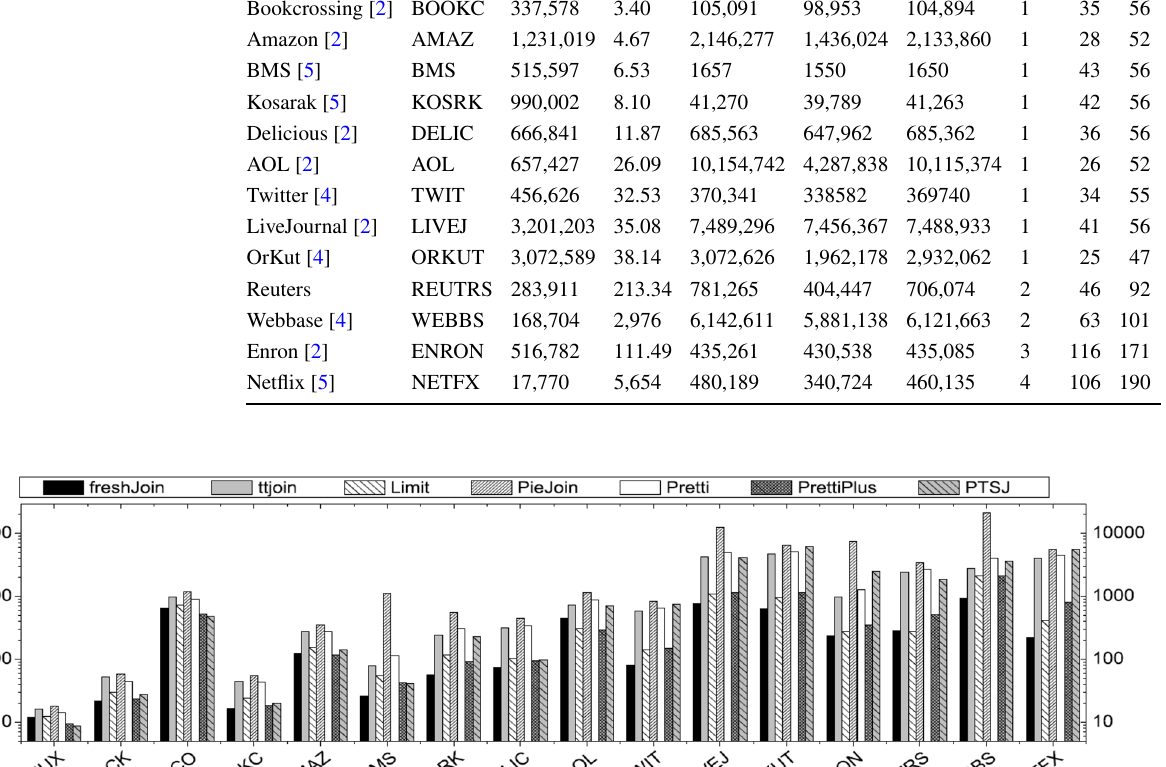
1 http://konec t.uni-koble